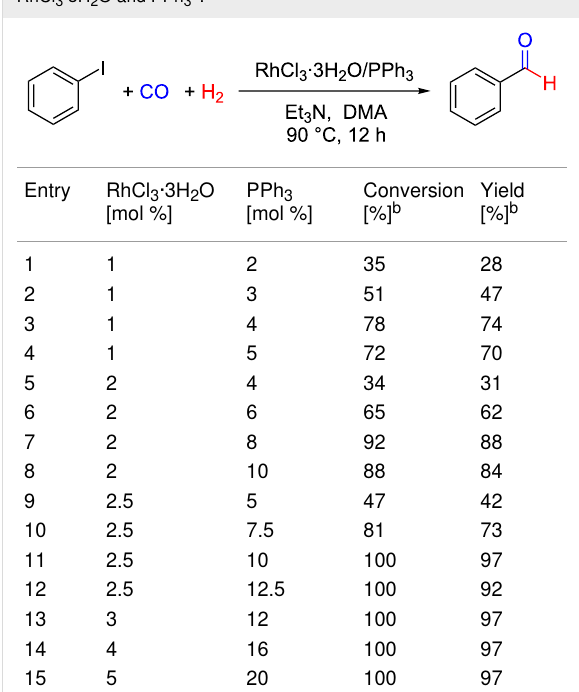
Table 4: Rhodium-catalyzed reductive carbonylation of iodobenzene with CO and H 2 to afford benzaldehyde: effects of dosage of RhCl 3 ·3H 2 O and PPh 3a